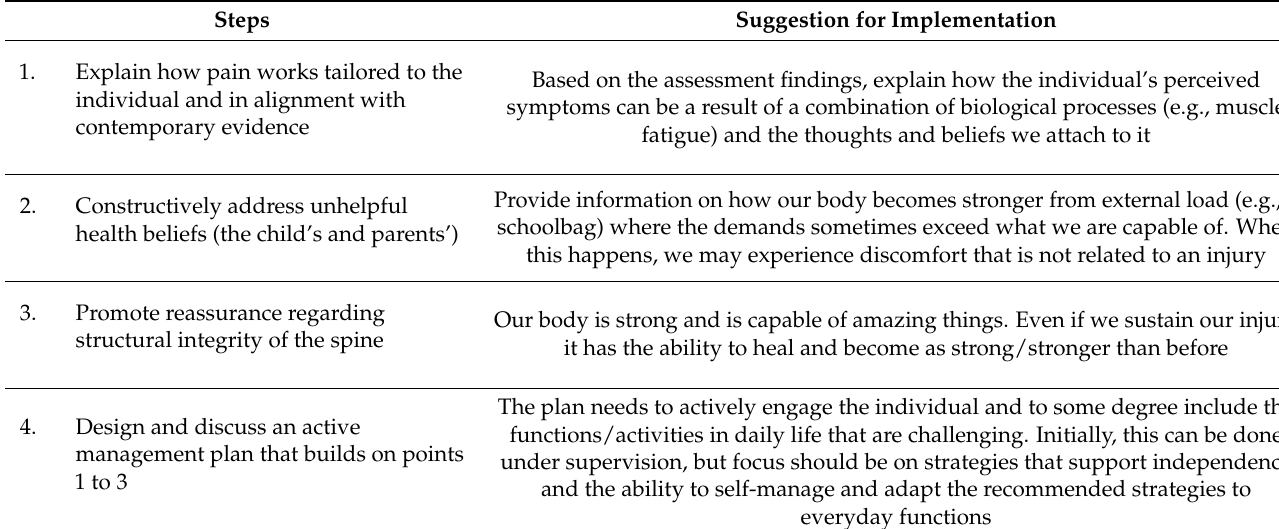
Table 1. An overview of important building blocks for designing a strategy that supports self-management in children and adolescents with spinal